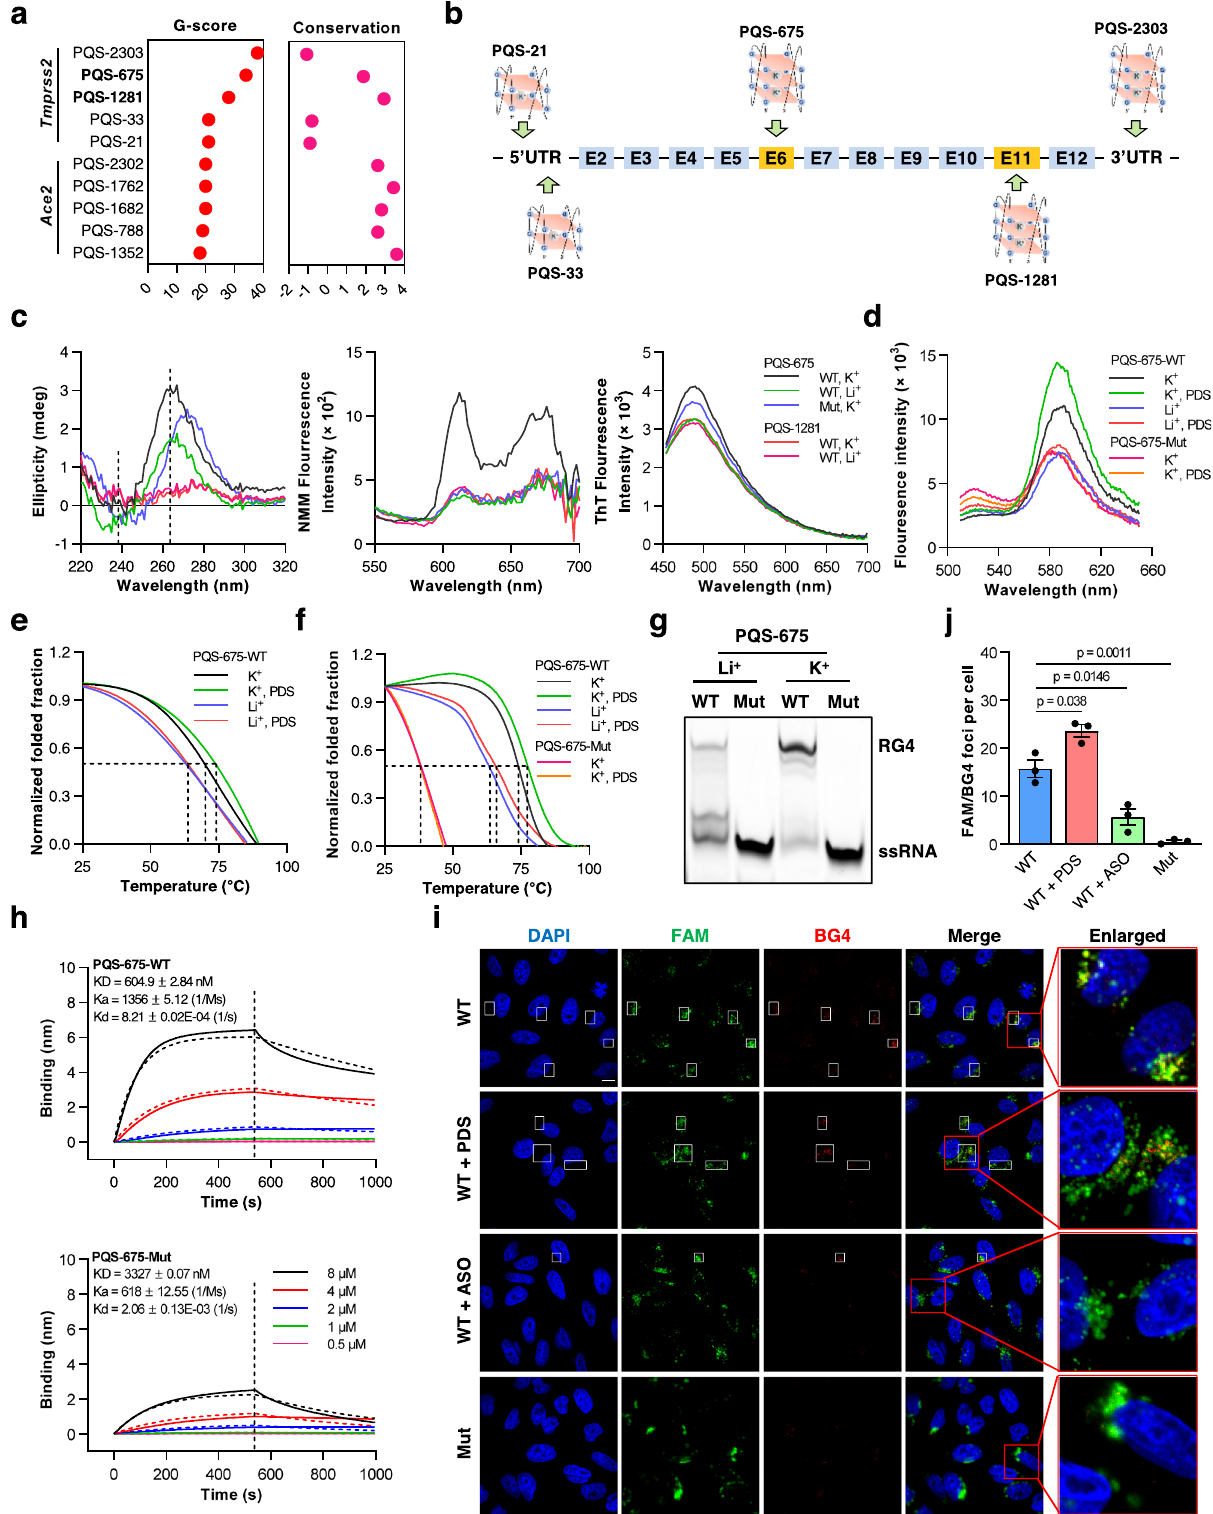
regulation. Thus, PQS-675 and PQS-1281 were used to exemplify the existence of RG4 in SARS-CoV-2 host factors. Under 150 mM KCl condition, the CD spectrum of PQS-675, but not PQS-1281, showed typical positive and negative molar ellipticity peaks (Fig. 1c). The fl uorescence emission spectrum further con fi rmed the ability of PQS-675, but not PQS-1281,